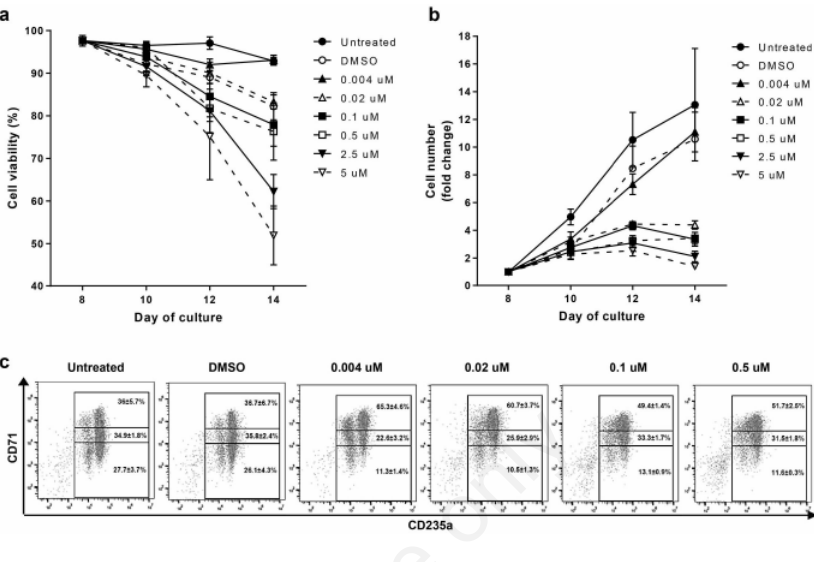
Figure 1. Effects of RN-1 treatment on cell viability, proliferation, and differentiation of 0 -thalassemia/hemoglobin E (HbE) patients. CD34 + cells erythroid cells derived from were differentiated to erythroid cells in the presence of RN-1 at the indicated concentra- β tions or vehicle control (DMSO) in days 8-14 of culture. Untreated culture condition (UNT) and DMSO treatment were used as the negative control. (a) Cell viability and (b) cell proliferation assessed by trypan blue staining (mean±SEM, n=4). (c) Representative flow cytometry dot plots for erythroid cell differentiation analysis of cells day 14 of cul- ture.